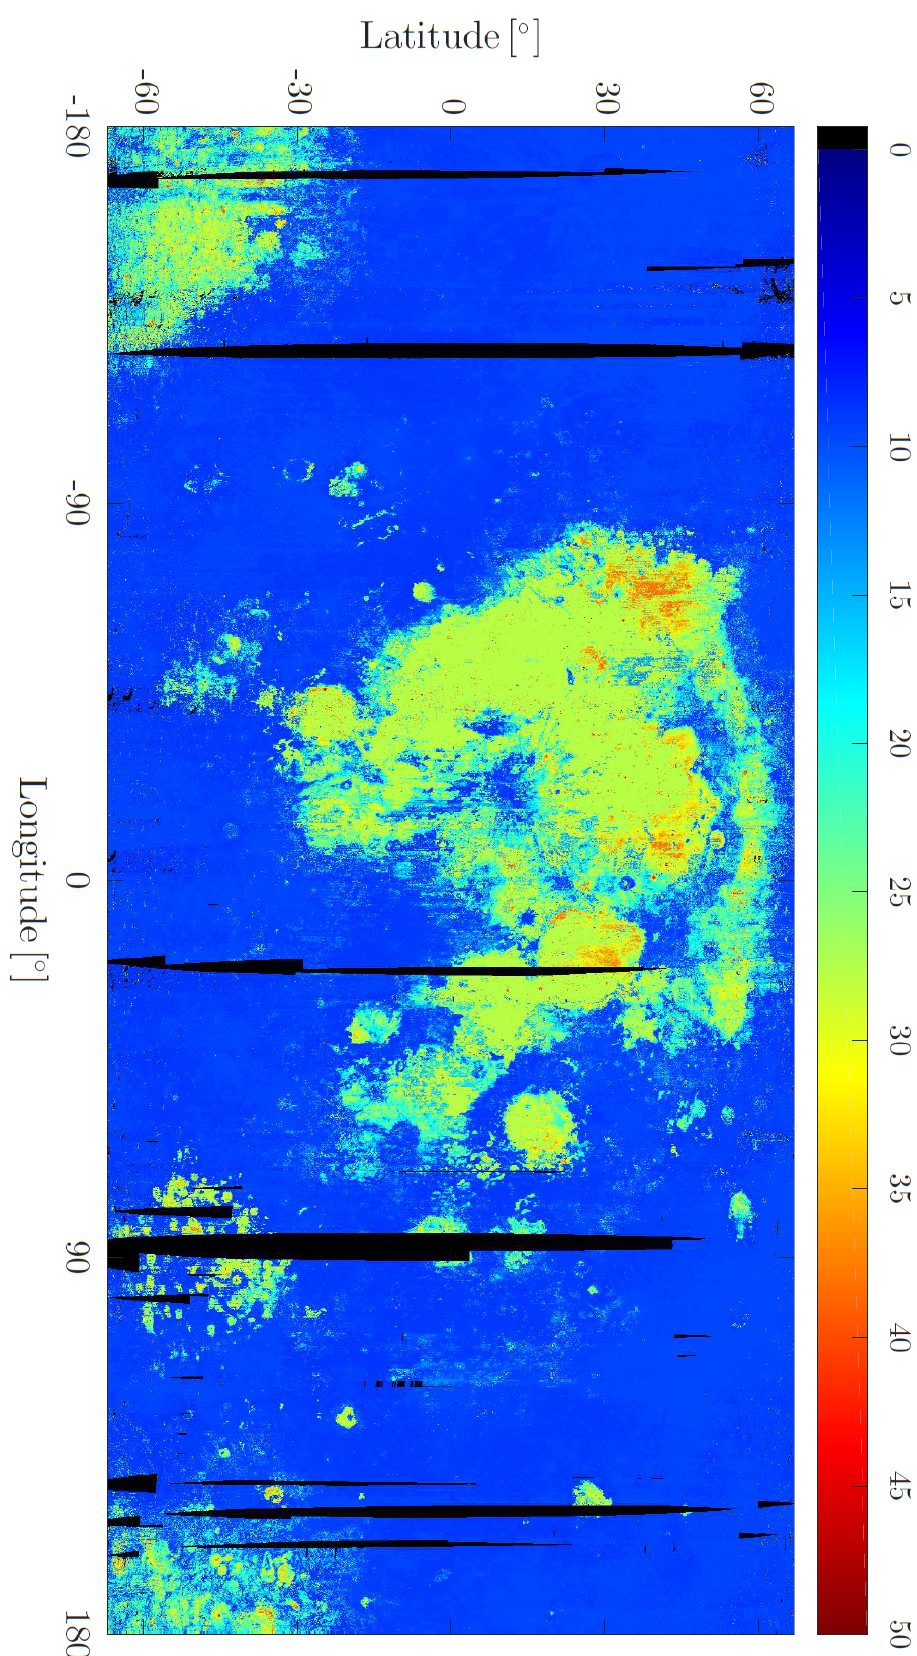
Figure 2. Map of the fractional abundance of pyroxene (in percent). Black pixels denote missing